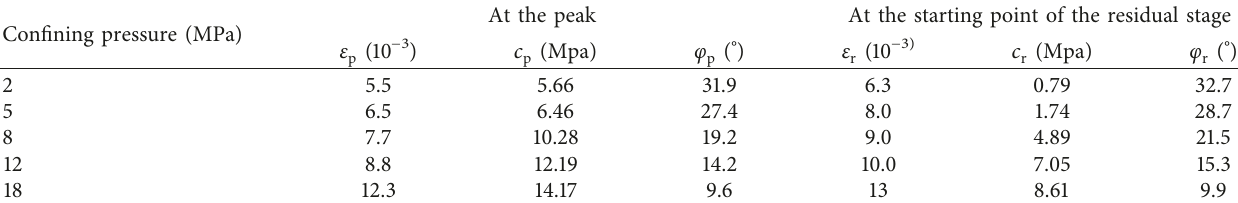
Table 1: Data of the Hawkesbury sandstone in triaxial compression tests.